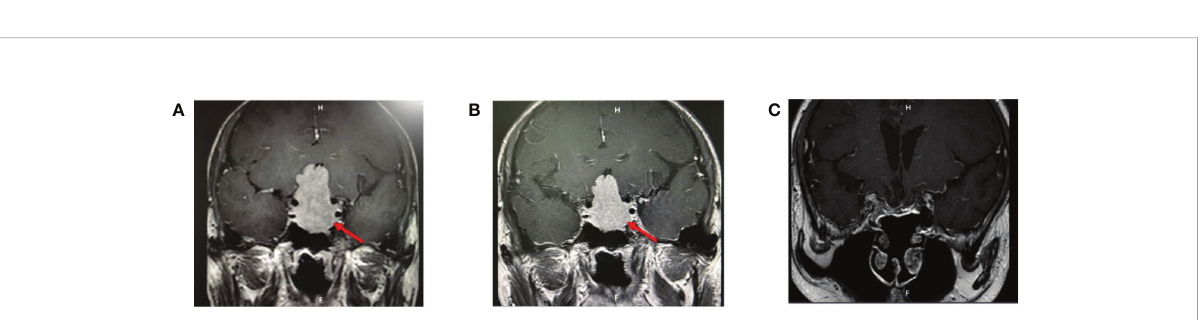
FIGURE 1 (A) Inhibition assay before treatment with glucose. (B) Inhibition assay before treatment with somatostatin. (C) Postoperative reports of the glucose suppression test. GH, growth hormone; TSH, thyroid-stimulating hormone; FT3, free triiodothyronine; FT4, free thyroxine.